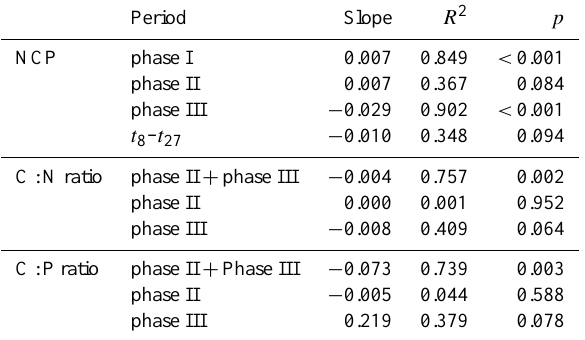
Table 2. The results of the F test on linear regressions between NCP, C:N, C:P uptake ratios in different phases and the mean p CO 2 for the corresponding